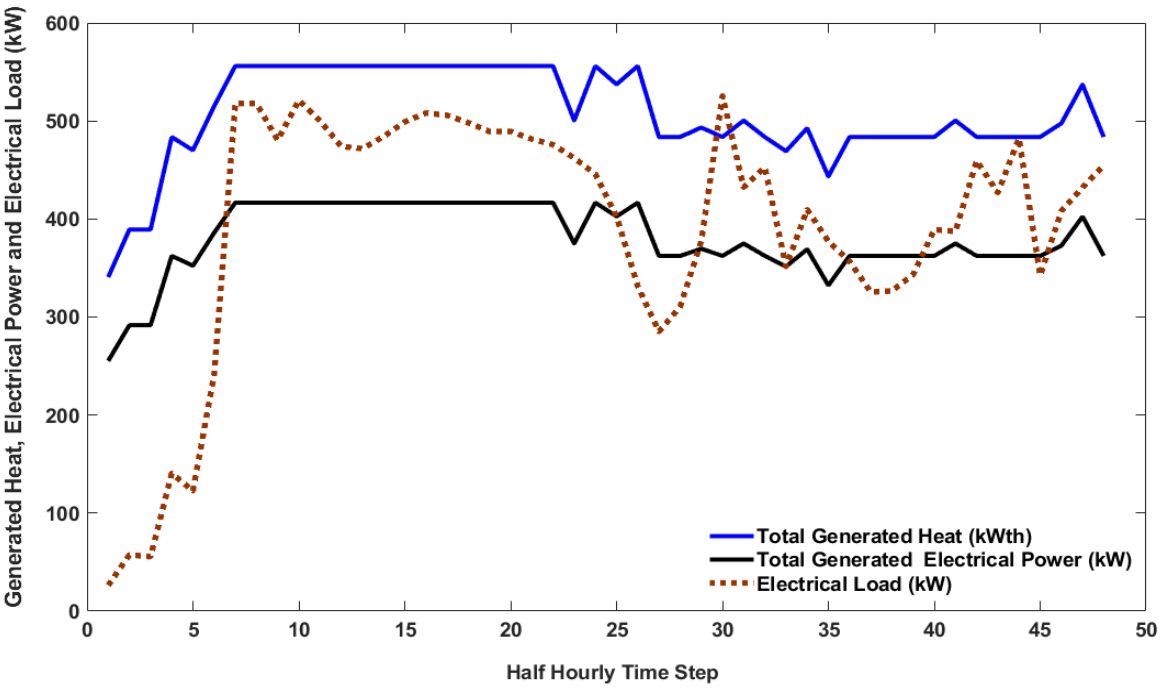
Figure 8. Total output electrical power and heat generated from 2 × 250 kWe CHP units using predicted load demand data .